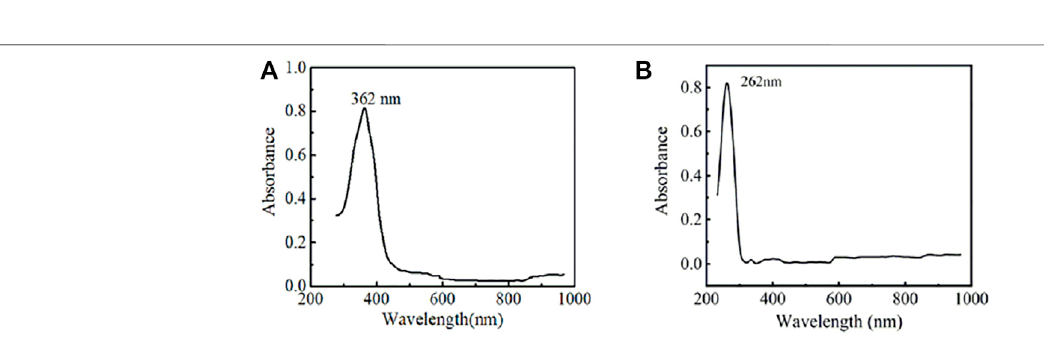
FIGURE 1 | The molecular structure of TPB-PSSO and EV 2+